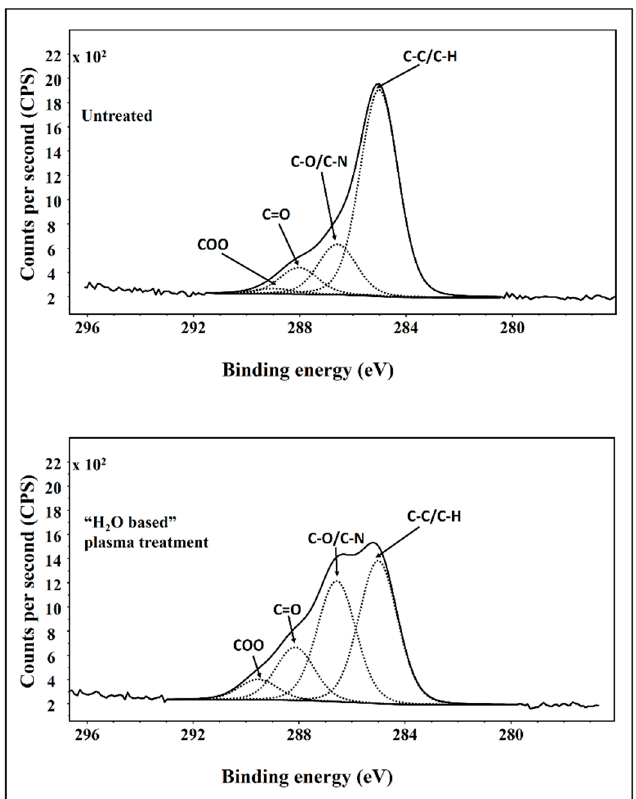
Figure 8. Component fitting of high-resolution C1s spectra of untreated and 10 s H 2 O-LPP-treated Bambara groundnut seeds. Bambara groundnut